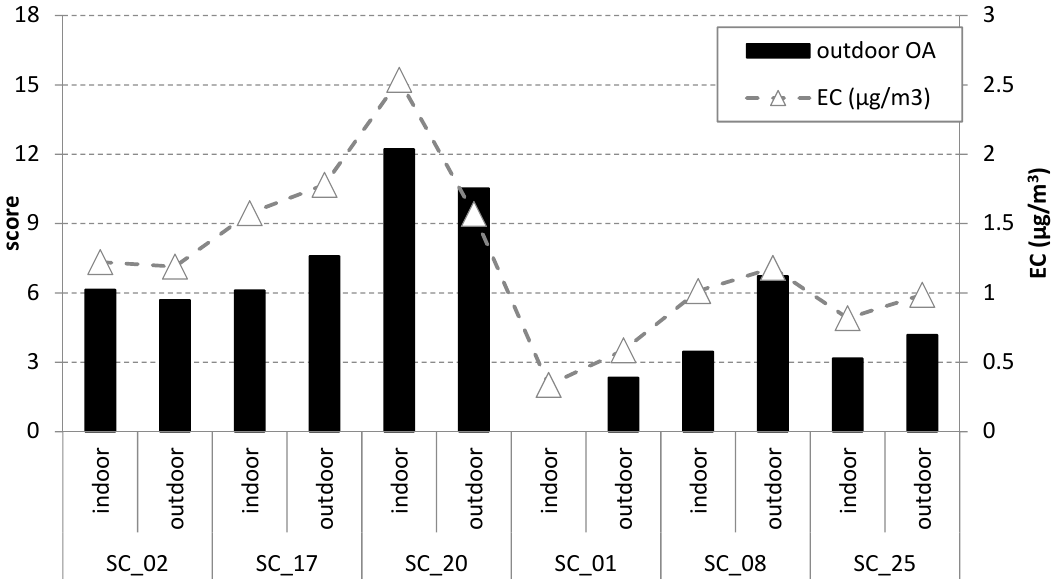
Figure 4. Score values of the outdoor organic aerosol component obtained by positive matrix factorization of the concentrations of the organic molecular tracers of the selected schools (left y -axis). The average EC concentration in the schools (right y -axis; µ g / m 3 ) is also displayed. The locations of the stations are shown in Figure 1.